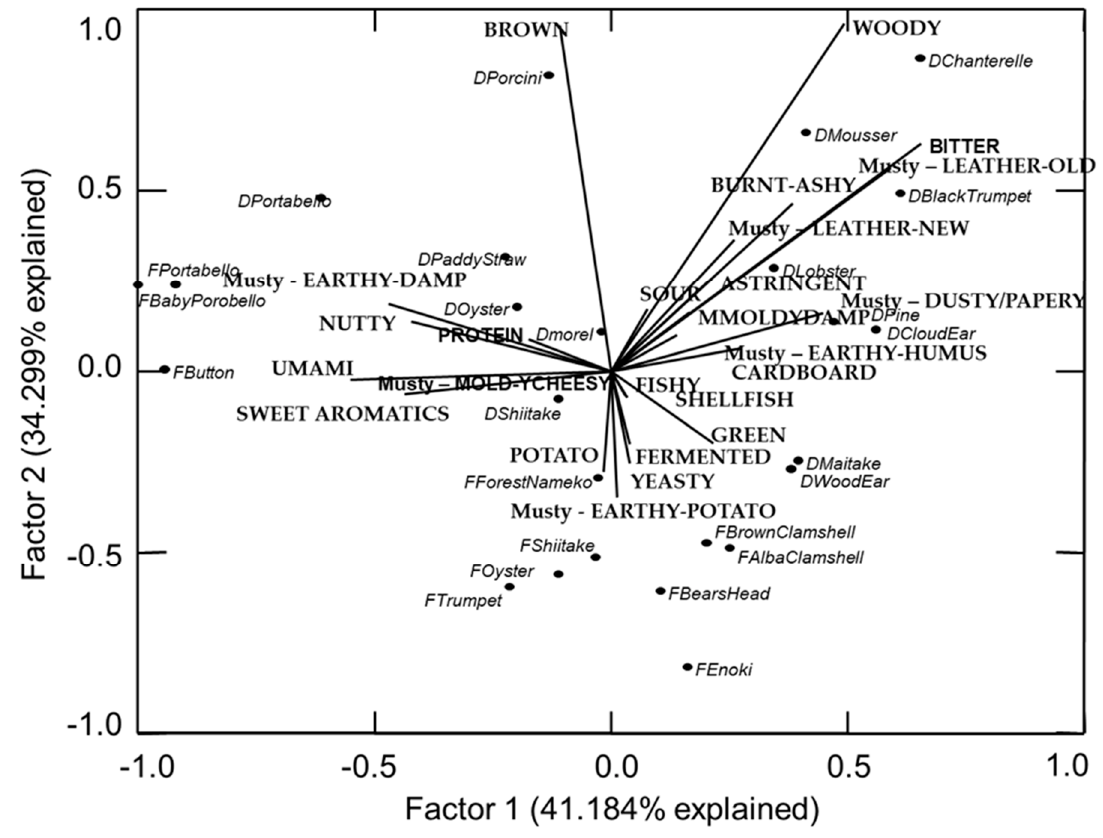
Figure 2. Principal component map of flavor notes and mushroom meat (fresh and reconstituted 22 Dried). 23